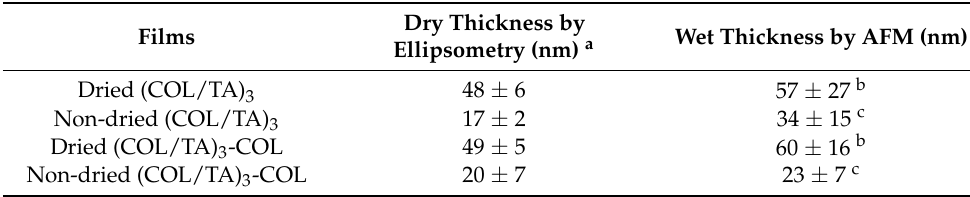
Table 1. Dry and wet films’ thickness of (COL/TA) 3 and (COL/TA) 3 -COL measured by ellipsometry and AFM, respectively.